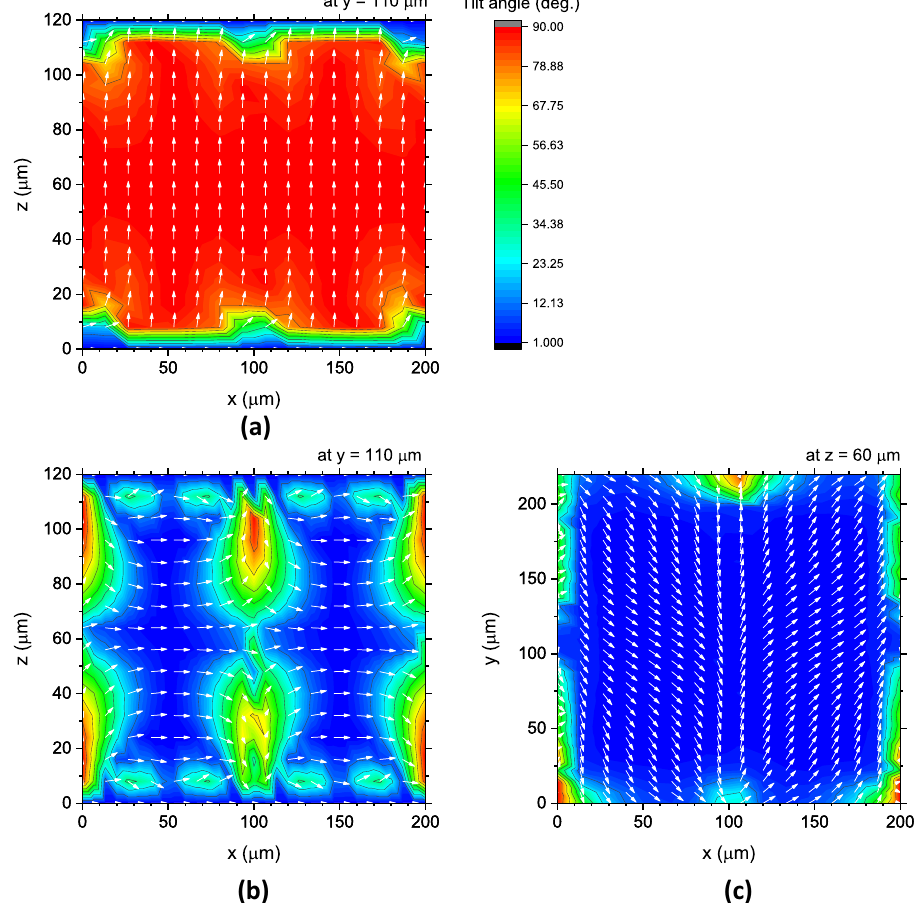
Figure 2. LC director distributions in the unit cell of x: 200 × y: 220 µm; ( a ) in the x–z cross-section at the centre of the y-axis under the out-of-plane state of 100 V, and ( b ) in the x–z cross-section at the centre of the y-axis and ( c ) in the x–y horizontal section under the in-plane states of 100 V. The colours indicate the tilt angle from the surface, and the white arrows are LC directors.